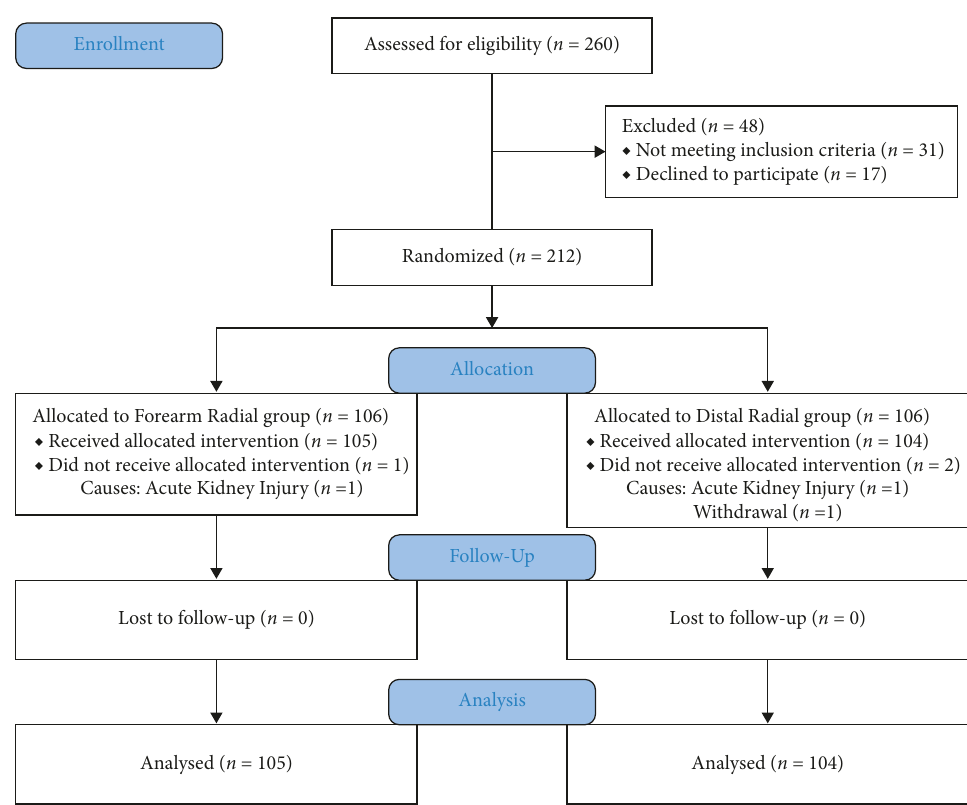
Figure 3: Flow of